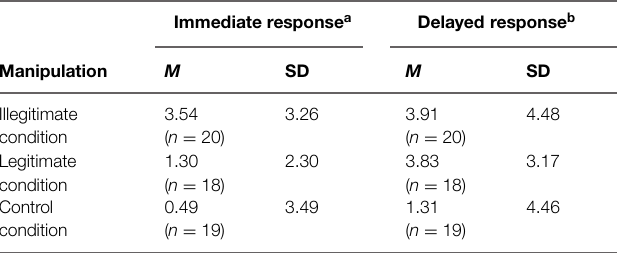
TABLE 1 | Means and SD for the ANOVA as a function of the experimental manipulation: immediate response and delayed response concerning heart rate (HR).